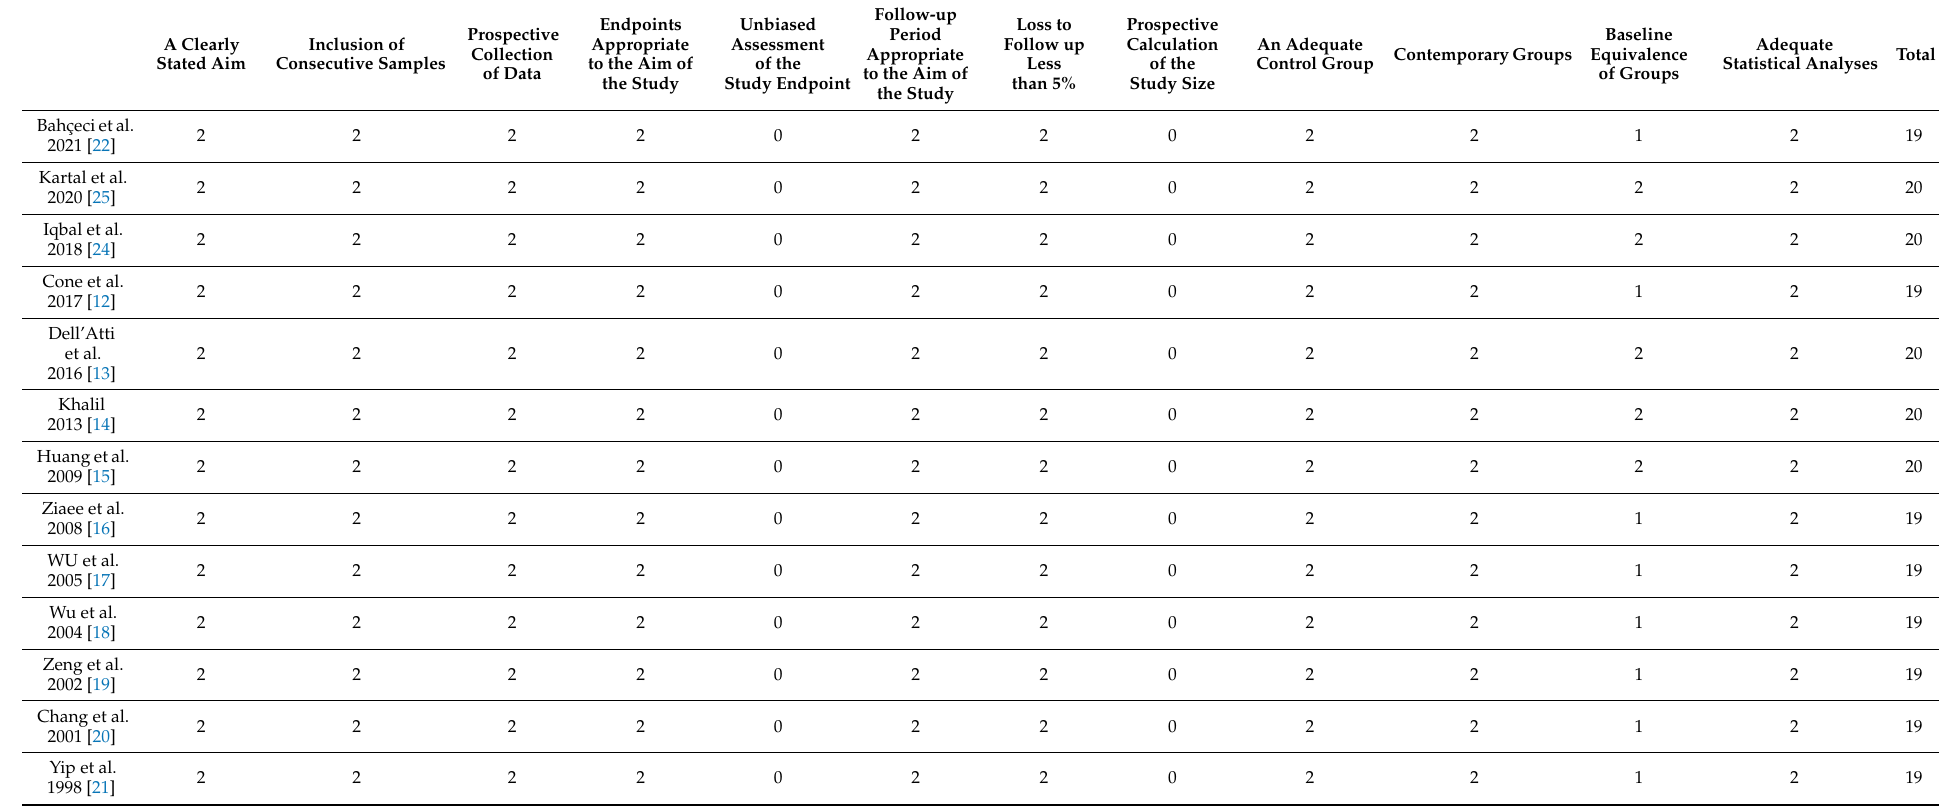
Table 2. MINORS score in nonrandomized studies included in the